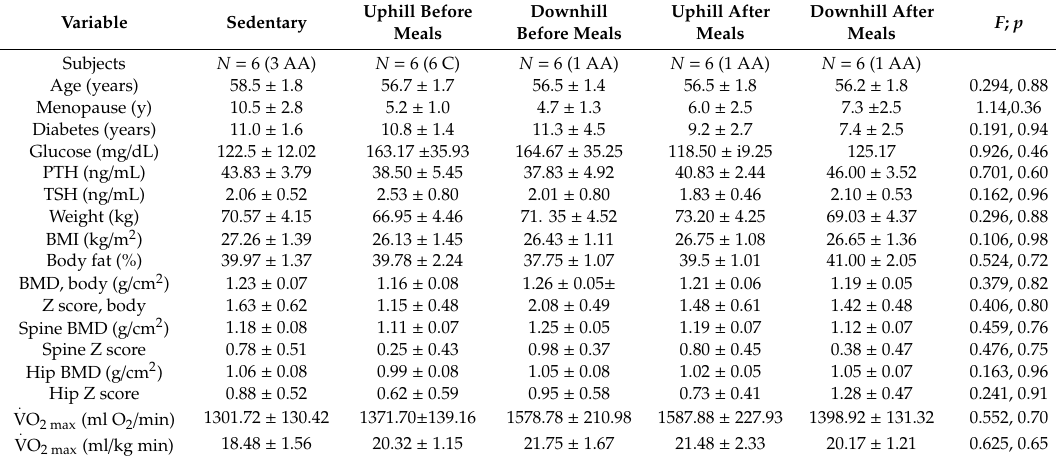
Table 1. Subject